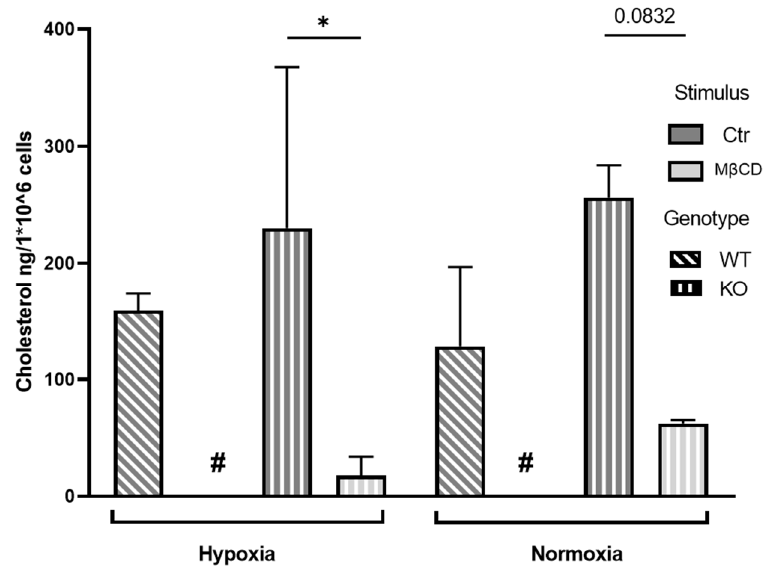
Figure 6. Cellular cholesterol levels of bone marrow-derived murine neutrophils after incubation under hypoxia. In the KO samples, M β CD stimulation resulted in a significant reduction of the cellular cholesterol level. Cellular cholesterol levels after incubation under normoxia revealed a tendency to reduce cholesterol levels in the KO after M β CD treatment, “#” indicates values were below the detection limit of 10 ng thus statistical analysis was not possible for these samples. However, a strong reduction of cellular cholesterol levels seems apparent. Statistical analysis was performed via mixed-effect-analysis with subsequent multiple comparisons. N = 3. (* p < 0.05).